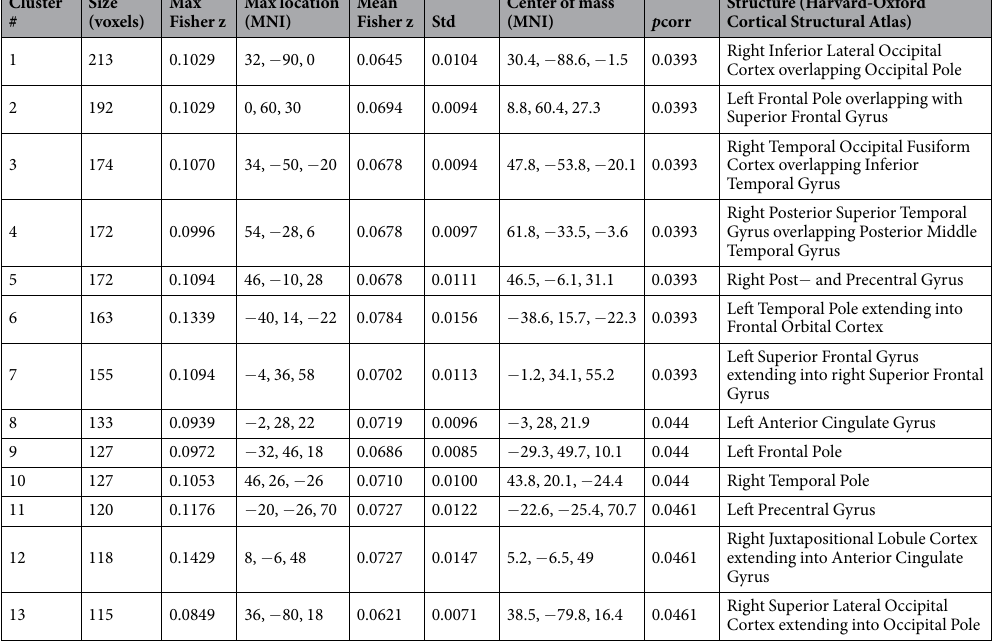
Table 3. Clusters from the cue period that showed significant correlated activity patterns with the HMAX C1